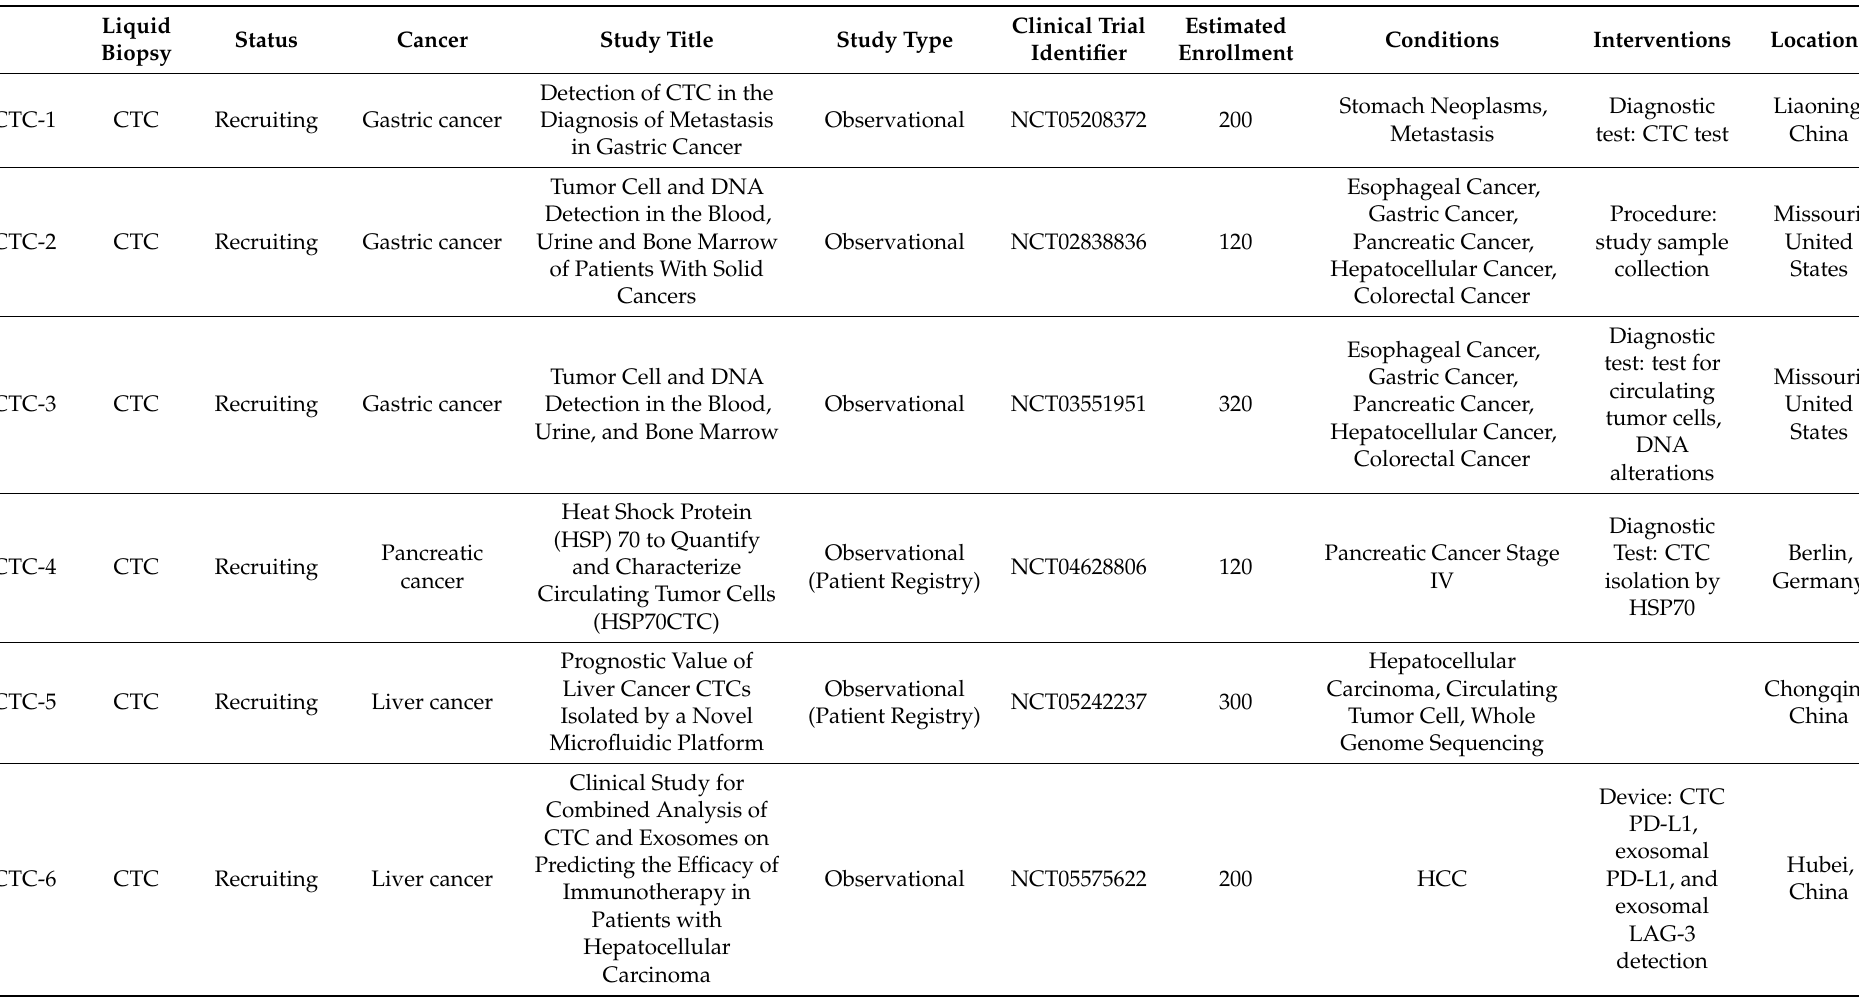
Table 5. Observational study with ongoing clinical trials of LB in